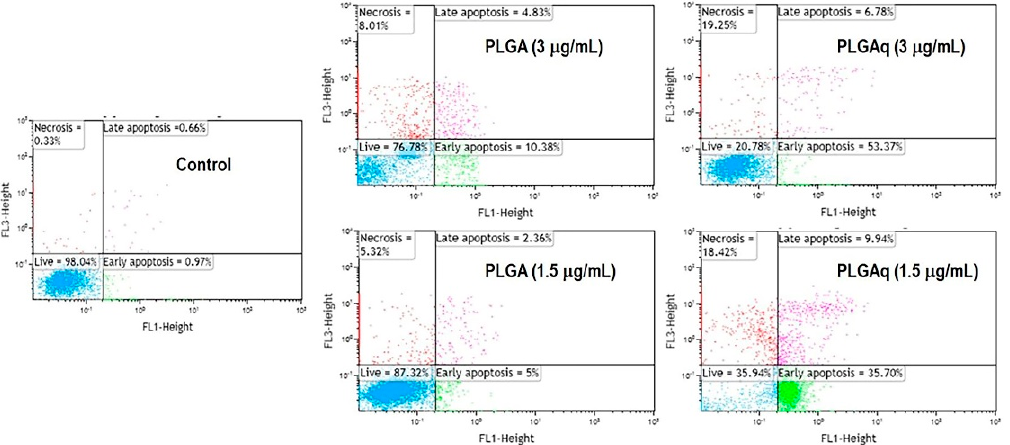
Figure 3. Effect of PLGAq on the induction of apoptosis in MCF-7 cell line detected by Annexin V-FITC and PI double-staining method. At a concentration of 1.5 µ g, the early and late apoptosis rates of PLGA microspheres were 5% and 2.36% respectively; at a concentration of 3.0 µ g, the early and late apoptosis rates of PLGA microspheres were 10.38% and 4.83% respectively. At a PLGAq concentration of 1.5 µ g, 35.70% and 9.94% apoptosis (early and late) was observed. When the concentration was increased to 3.0 µ g, the apoptosis rate (early stage) was 53.37% and 6.78% in the late stage. A significant increase in the number of apoptotic cells was observed with increasing concentrations of PLGAq after administration. [45]. Copyright 2019,